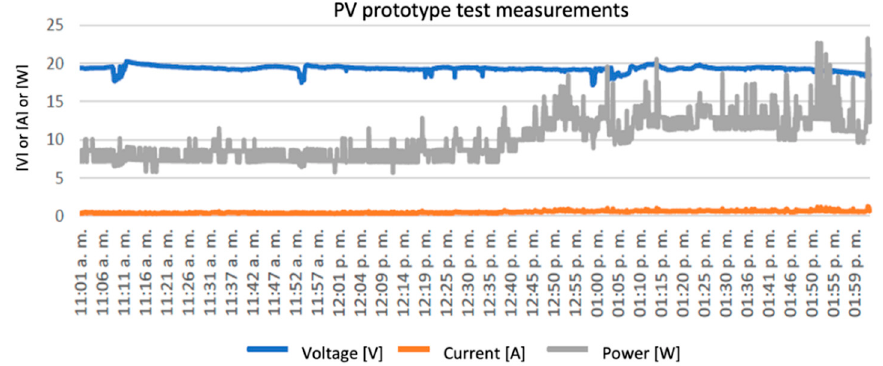
Figure 4. Voltage, current, and power measurements from the prototype solar-based system (mea- surements taken 21 February 2021).